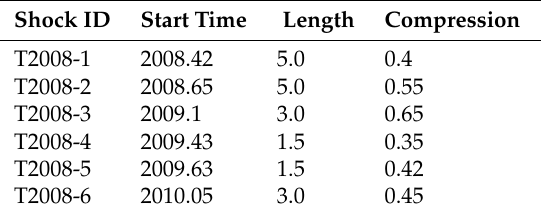
Table A3. Shock attributes for T2008.